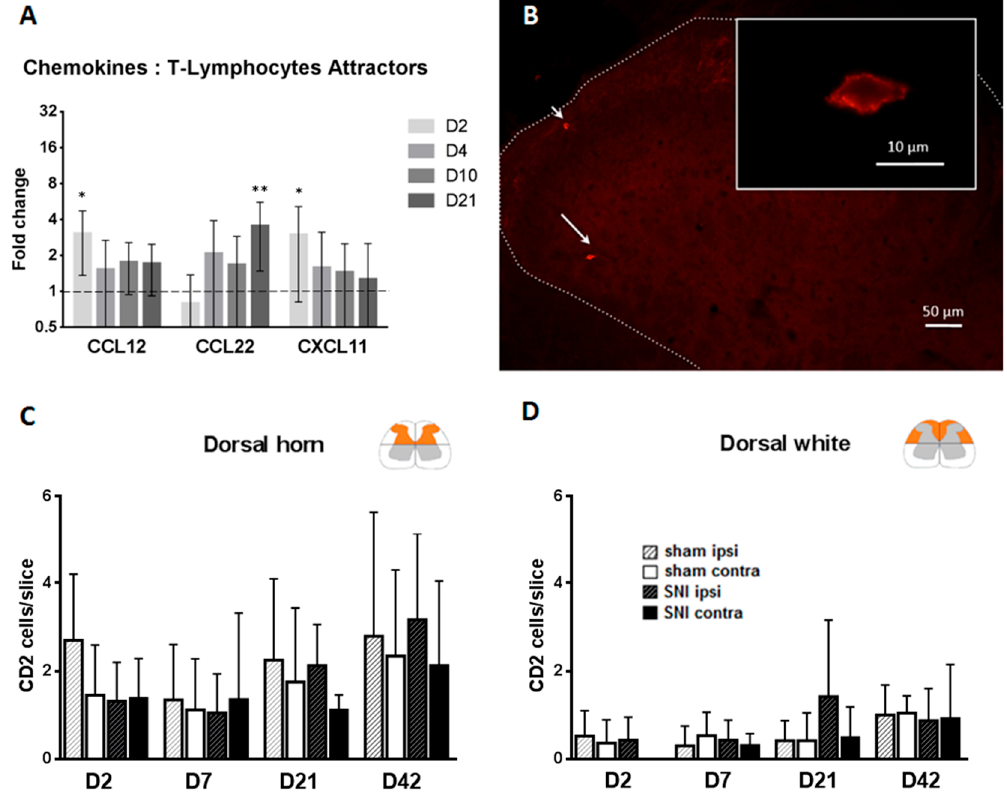
Figure 5. CD2-positive T-cell infiltration in the lumbar spinal cord. ( A ) Expression of genes of T-cells attractors in the spinal cord of rats following SNI from the RT-qPCR array showing the upregulation of gene expression of T-lymphocytes attractors. * p < 0.05, ** p < 0.01. Student’s t -test: Naive (not shown) vs. SNI. N = 6 for each time point (D2, D4, D10 and D21); ( B ) Immunofluorescence of the ipsilateral dorsal horn showing CD2+ cells (pointed by arrows) in the spinal cord seven days after SNI; Insert: Magnification of the cell pointed by the longest arrow ( C , D ) Bar histograms showing the number of CD 2+ cells detected in sham or SNI at days 2, 4, 10 and 21 in the ipsilateral or contralateral side to SNI. Two regions of spinal cords were analyzed: C , the dorsal horn and D , the dorsal white matter. N = 4/groups. Values are expressed as mean ± 95% CI. No significant difference, 2-way ANOVA with Sidak correction.